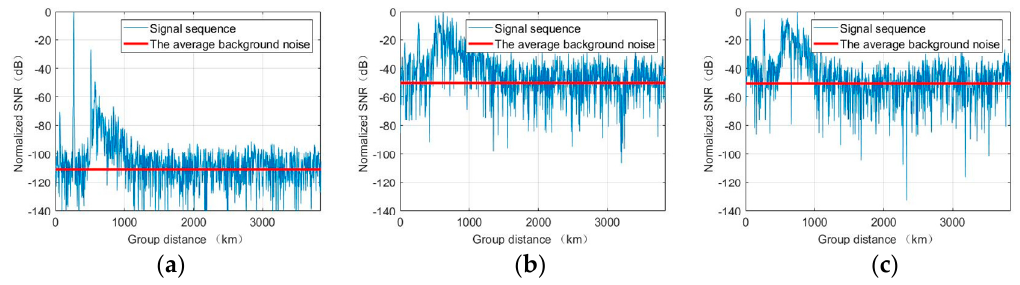
Figure 15. Normalized SNR of 5.2 MHz; ( a ) Channel 1; ( b ) SMI; ( c ) ESB.